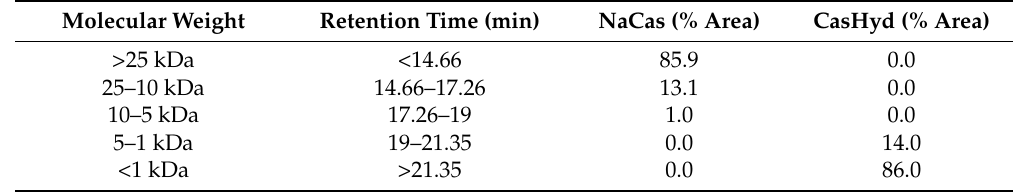
Figure 3. Size exclusion HPLC for CasHyd fraction compared with parent casein protein. Molecular weight distribution of CasHyd and parent protein, sodium caseinate (NaCas), expressed as absorbance over time on HPLC chromatogram. Table 2. Molecular weight distribution of NaCas and CasHyd.